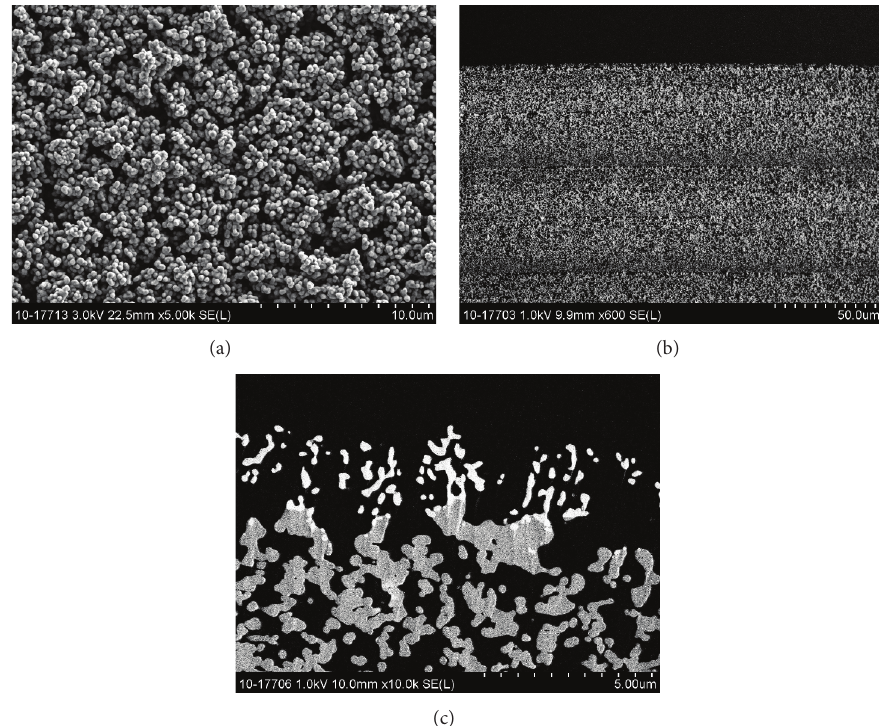
Figure 3: SEM images of the surface (a) and the cross-section (b) of the porous TiO 2 -coated a-silica glass tube and a high-magnification SEI of cross-section of stacked TiO 2 layers over a-silica layers